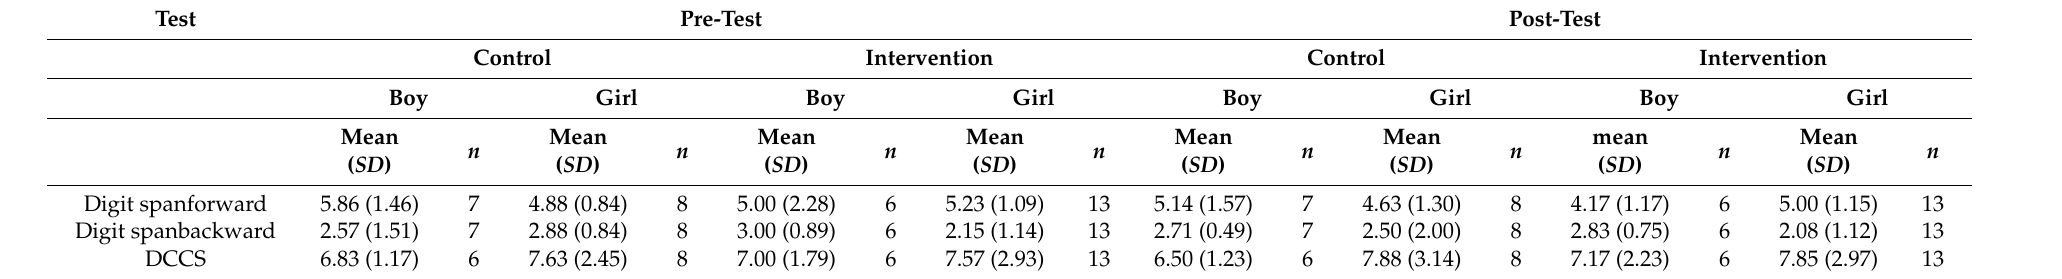
Table A4. Achieved digit span and DCCS scores of those participants who participated in both pre- and